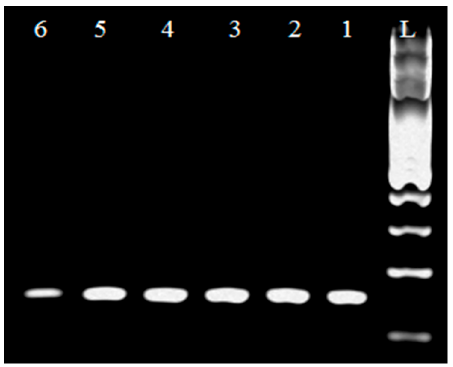
Figure 2. Identification of genus Lb. johnsonii. L: 100 bp ladder standard; lines 1, 2, 3, 4, and 5: Lb. johnsonii isolates (750 bp); line 6: Lb. johnsonii reference strain CCM 2935.